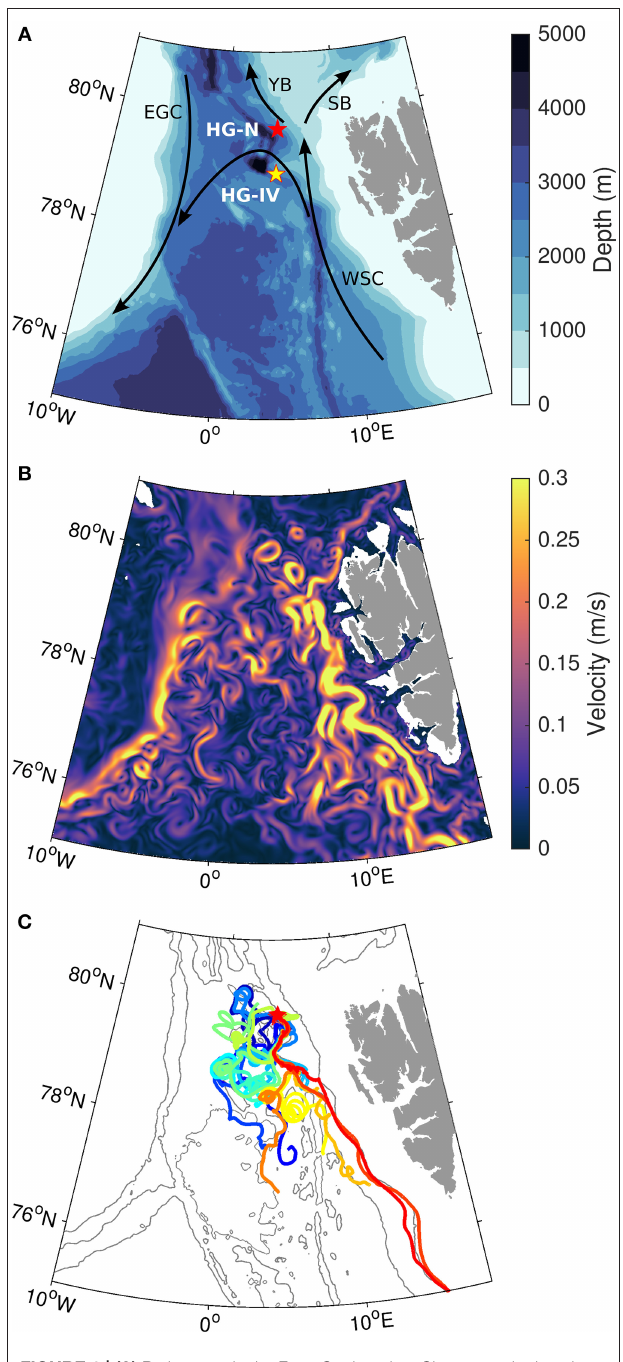
FIGURE 1 | (A) Bathymetry in the Fram Strait region. Shown are the locations of the two moorings, HG-N (red star) and HG-IV (yellow star). Indicated are also major currents in the Fram Strait: West Spitsbergen Current (WSC), East Greenland Current (EGC), Yermak Branch (YB) and Svalbard Branch (SB). (B) Snapshot of simulated velocity in 100 m depth on 1 July 2009. (C) 115-day long backward trajectories of particles calculated with a settling velocity of 20 m/d released at HG-N in 2,300 m depth in the time period 1–14 July 2009. Each color indicates a different release date. Gray contours show the bathymetry at 1,000 m